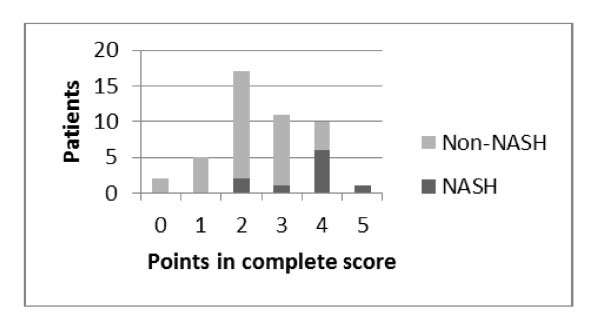
Number of patients with NASH according to the number of points of a simplified score system.